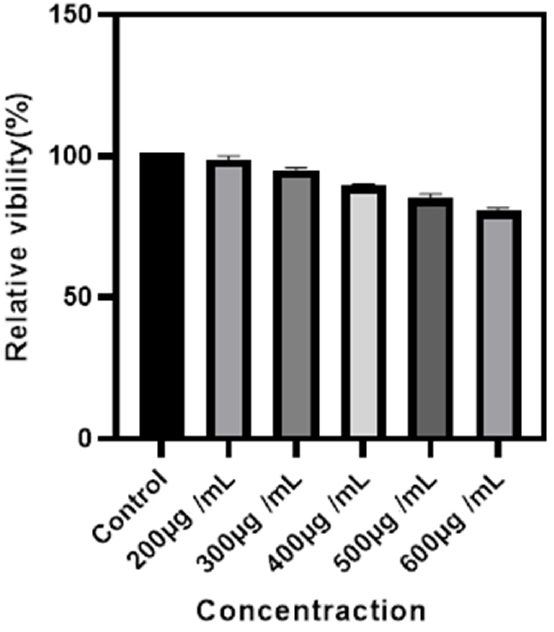
Figure 10. Cytotoxicity of different concentrations of Ag-UCNPs@SiO 2 . A 200 µ g/mL concentration of Ag-UCNPs@SiO 2 was intratumorally injected in the mice. Figure 11c shows that the tumor site of the mouse before injection has no signal under Micro-CT imaging; furthermore, 30 min after the injection of Ag-UCNPs-SiO 2 (Figure 11d), the tumor site of the mouse shows a CT signal. The results firmly demonstrate that the Ag-UCNPs@SiO 2 effectively serves as a contrast agent for CT imaging in vivo.